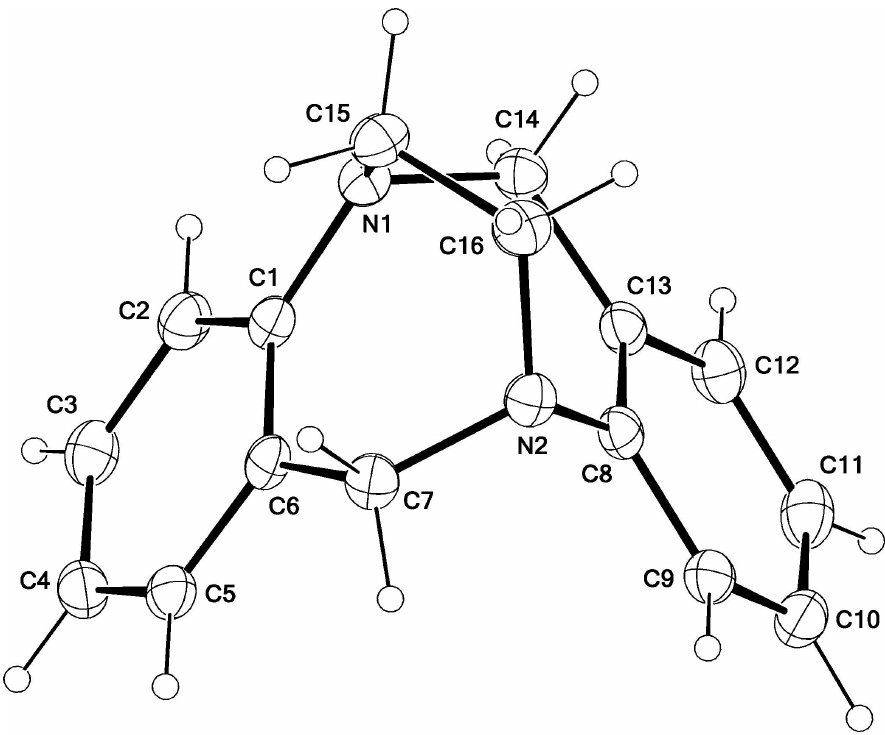
Figure 1 View of (I), showing the atomic numbering scheme. Displacement ellipsoids are shown at the 50% probability level.